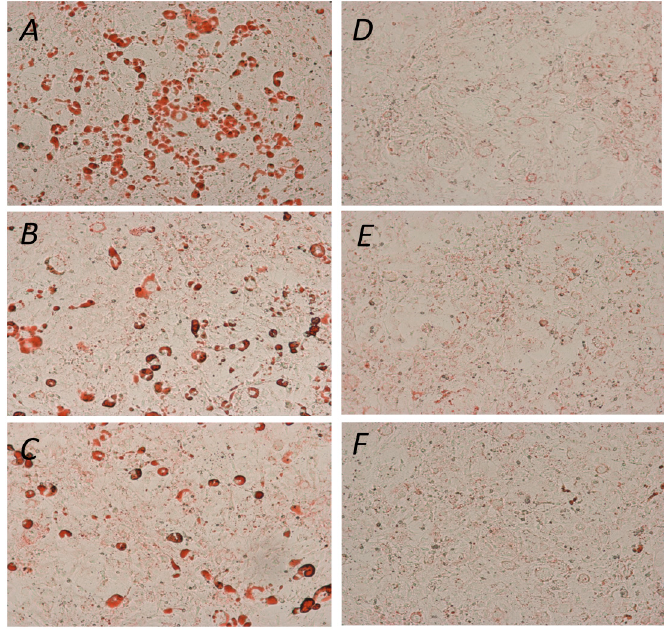
Figure 3. Effect of yerba maté , YGD and resveratrol on 3T3-L1 differentiation. ( A ) Control; ( B ) YGD (100 μ g/mL); ( C ) yerba maté (150 μ g/mL); ( D ) resveratrol (10 μ g/mL); ( E ) YGD + resveratrol (100:10 μ g/mL); and ( F ) yerba maté + resveratrol (150:10 μ g/mL). Adipogenic differentiation was assessed using Oil Red O staining for lipid droplets 100